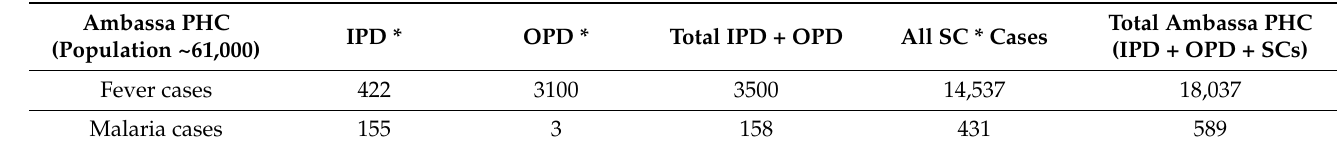
Table 1. Total no. of fever and malaria cases reported in Ambassa PHC * during April 2019 to March 2020 period.